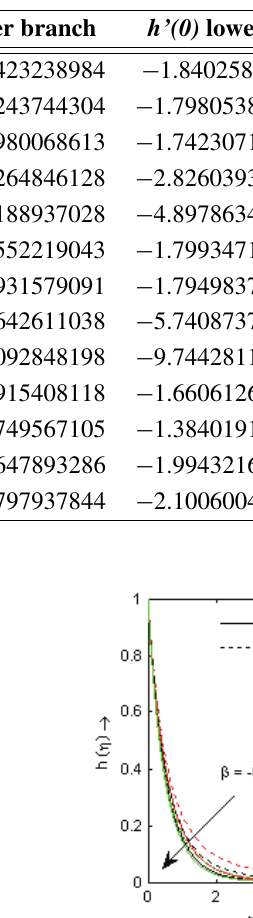
Table 1. Values of temperature gradient h ’(0) for various values of s, M, k, Pr, r and ˇ .